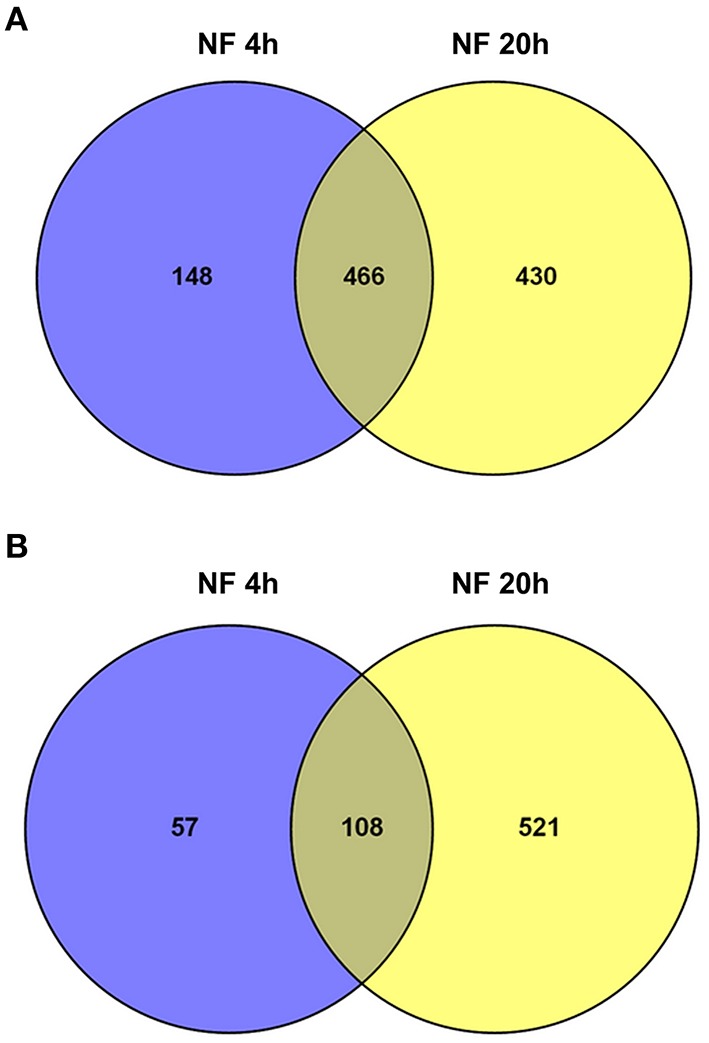
Overview of significantly regulated genes identified in Medicago truncatula root hairs after Nod factor treatment. Venn diagram summarizing the number of differentially expressed genes in the two time points following NF treatment, and their respective overlaps. (A) Up-regulated genes (6.1% of the genes expressed in root hairs). (B) Down-regulated genes (3.9%).